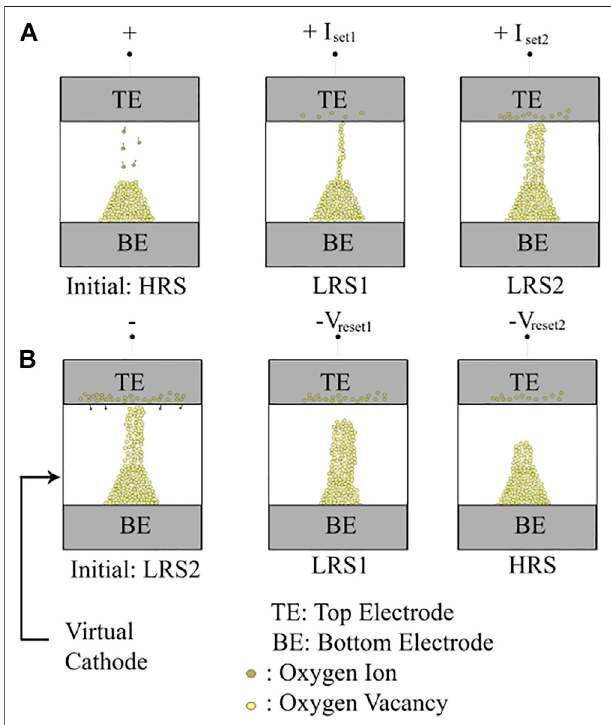
FIGURE1| Multi-levelswitchinginternaryReRAM: (A) H2Land (B) L2H programming.